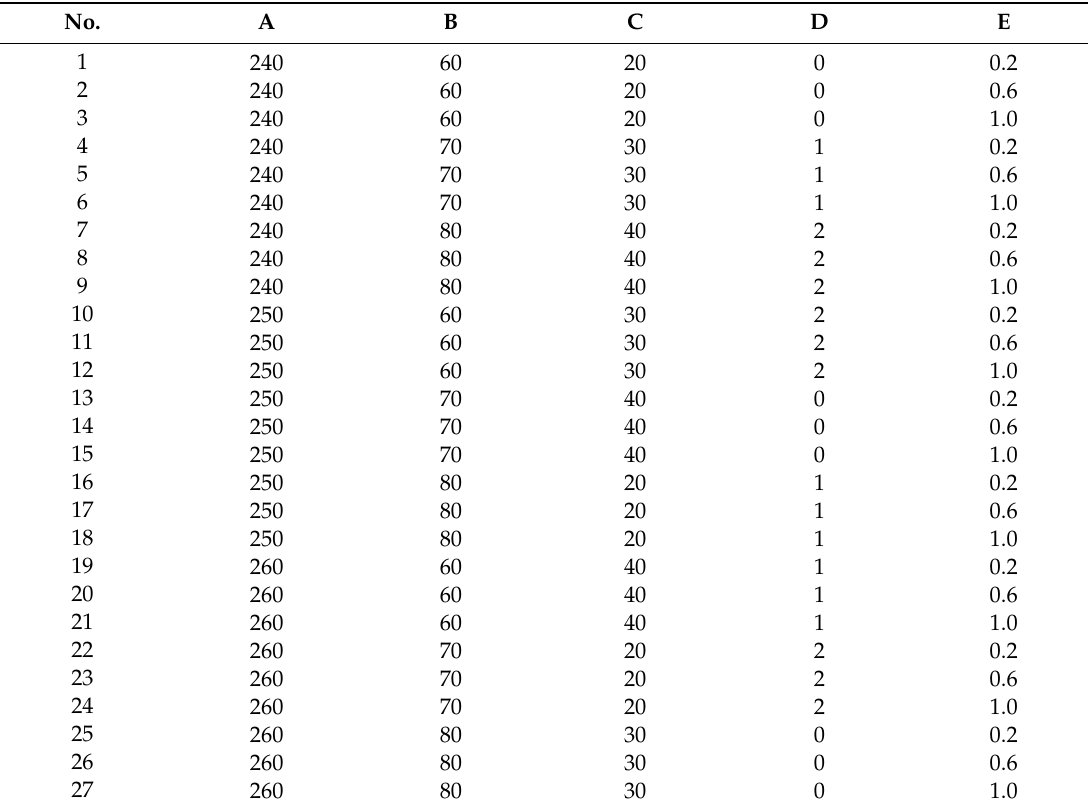
Table 3. Design of